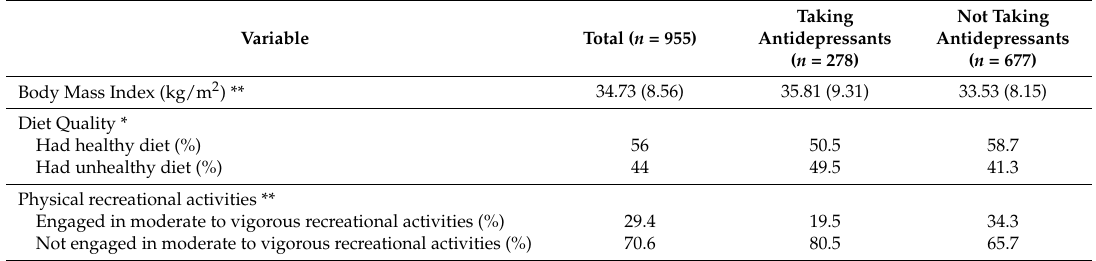
Table 4. Behavioral characteristics of patients with type 2 diabetes and depression symptoms.